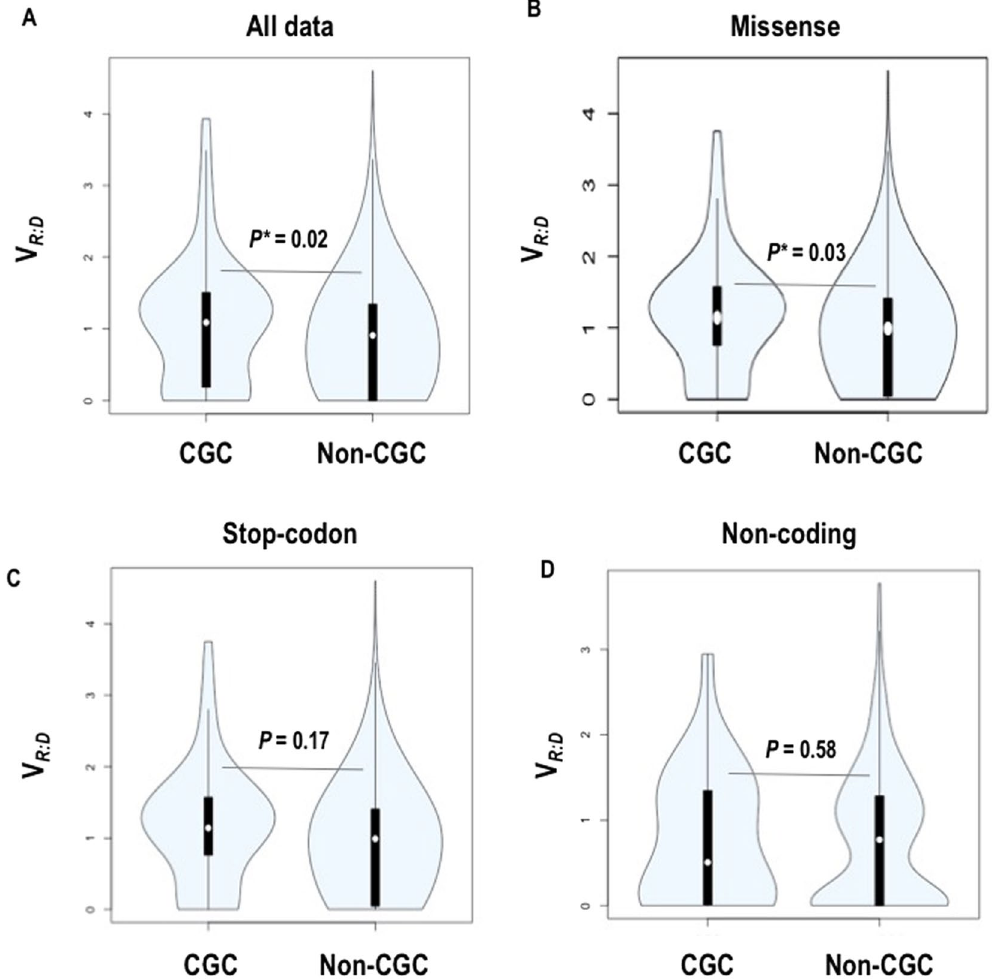
Figure 4. V R:D in the CGC vs non-CGC genes ( A ), in missense variants ( B ), in stop-codon variants ( B ), and in non-coding